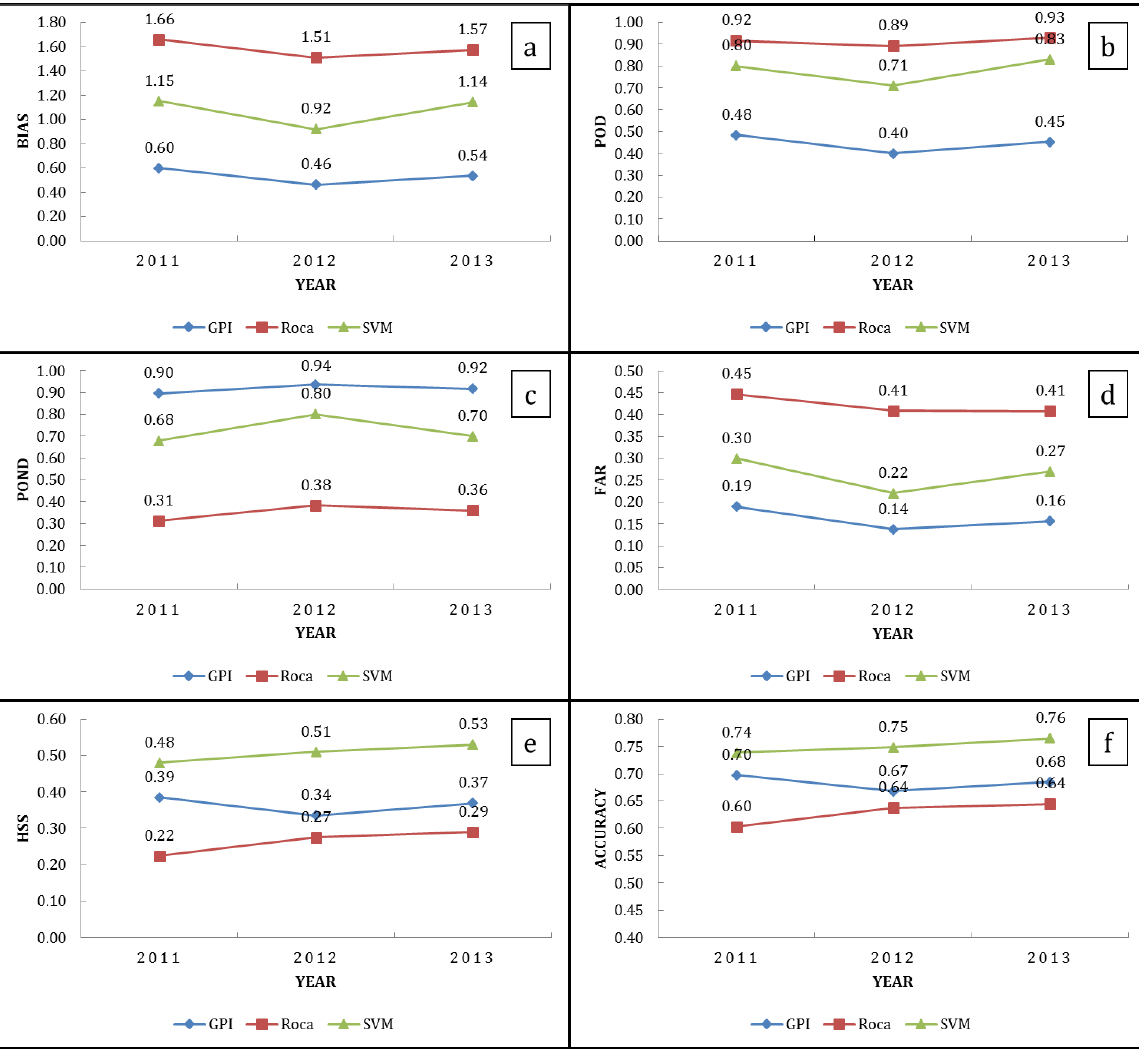
Figure 6. Categorical statistics for S/W monsoon months of the years 2011-2013 and for different rain detection indices. a) BIAS b) POD c) POND d) FAR e) HSS f)